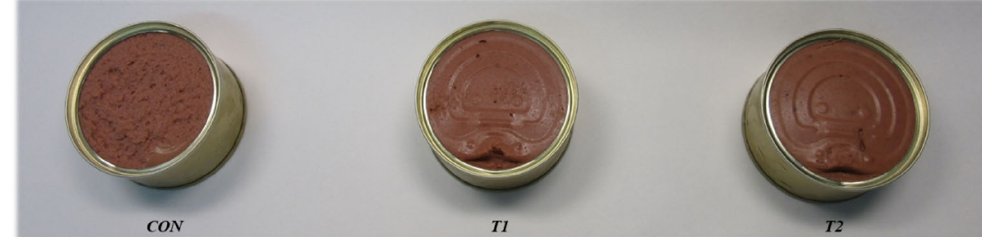
Figure 1. Appearance of foal p â t é s. CON: p â t é prepared with 100% foal dorsal fat; T1: p â t é prepared with 50% of foal fat replaced with microencapsulated walnut and algal oil mixture; T2: p â t é prepared with 50% of foal fat replaced with microencapsulated pistachio and algal oil mixture. The chemical composition and lipid oxidation of the fat sources employed (Table 1) and the fatty acid profiles of the foal fat and oils included in the manufacturing process (Table 2) were determined according to the same procedures used for the p â t é samples (Section